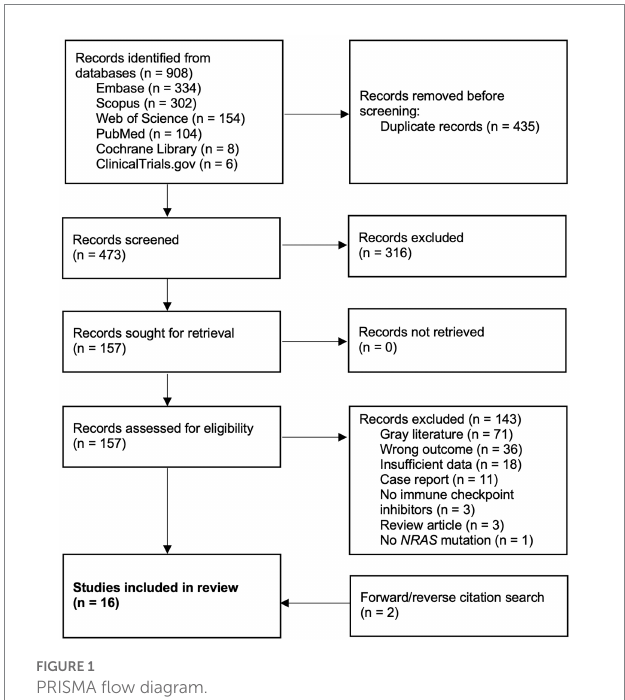
FIGURE 1 PRISMA flow